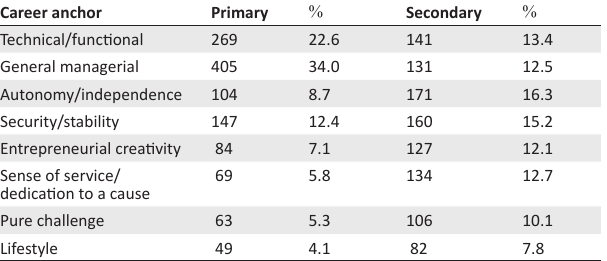
TABLE 11: Primary and secondary career anchors in the medium term (4 to 10 years). Career anchor